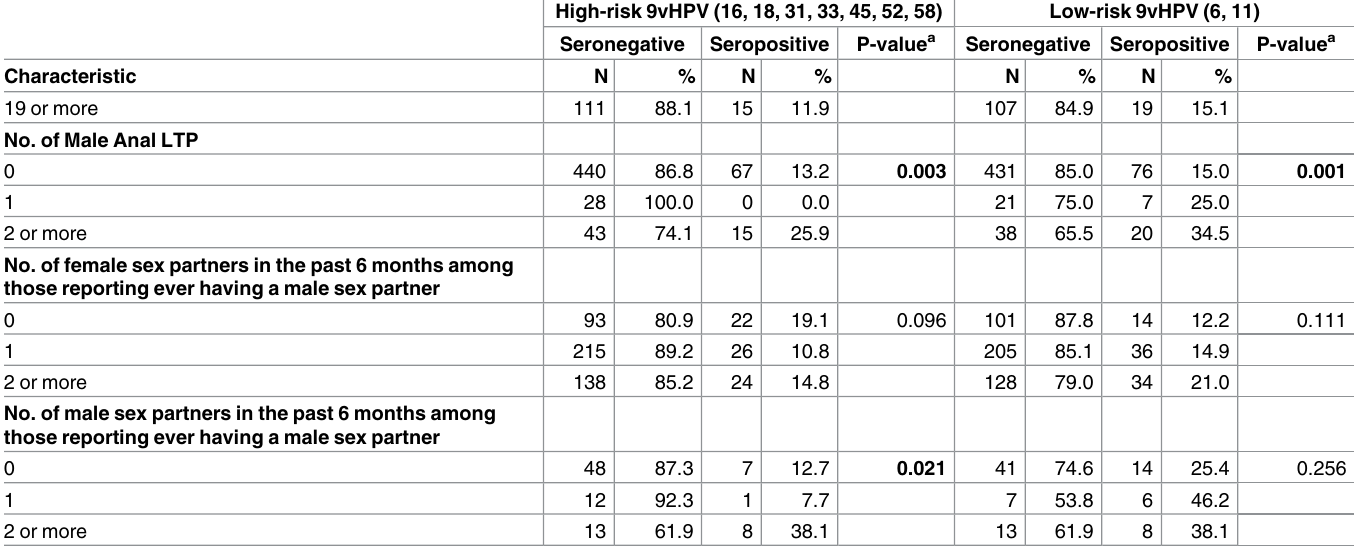
for high-risk 9vHPV (p < 0.05). Significant differences in seropositivity to low-risk 9vHPV were observed by country, circumcision status, sexual orientation, and number of male anal sex LTP (p < 0.05). Grouped and individual type HPV seroprevalence estimates are presented in Table 2. Over- all, 28.3% of men were seropositive for (cid:21) 1 9vHPV type, 14.0% for (cid:21) 1 high-risk 9vHPV types, 11.2% for (cid:21) 1 of the five additional types, and 17.4% for low-risk 9vHPV types 6 and/or 11. Type-specific seropositivity for five individual HPV types was as follows: HPV 31 (4.5%), HPV 33 (1.7%), HPV 45 (3.7%), HPV 52 (2.5%), and HPV 58 (4.7%). Seropositivity for 9vHPV was statistically significantly different by country [Brazil (36.5%), Mexico (28.5%) and U.S. (19.0%); overall p < 0.001] and remained significant only for Brazil vs. U.S. (p < 0.001) after pairwise comparisons. No significant differences in the seroprevalence of grouped high-risk 9vHPV types was observed by country [Brazil (14.5%), Mexico (16.8%) and U.S. (10.3%); over- all p = 0.173]. Seroprevalence of the five-additional types also did not vary significantly by country [Brazil (10.5%) and Mexico (13.6) and U.S. (9.2%); overall p = 0.368]. Seropositivity to low-risk 9vHPV was statistically significantly different by country [Brazil (27.5%), Mexico (14.0%) and U.S. (10.3%); overall p < 0.001] and remained significant for Brazil vs. U.S. (p < 0.001) and Brazil vs. Mexico (p < 0.001) after pairwise comparisons. Seroprevalence of individual HPV types 6 and 16 significantly differed by country [Brazil (25.5%) and (5.5%), Mexico (13.6%) and (1.9%) and U.S. (9.2%) and (1.6%), respectively; overall p-values < 0.05]. After pair wise comparisons, significant difference remained for Brazil vs. U.S. (p < 0.001) and Brazil vs. Mexico (p = 0.004) only for HPV 6. Seroprevalence was highest for HPV 6 in all three countries [Brazil (25.5%), Mexico (13.6%) and U.S. (9.2%)]. Figs 1 and 2 show grouped and type-specific HPV seroprevalence by age group. A significant positive trend (p < trend